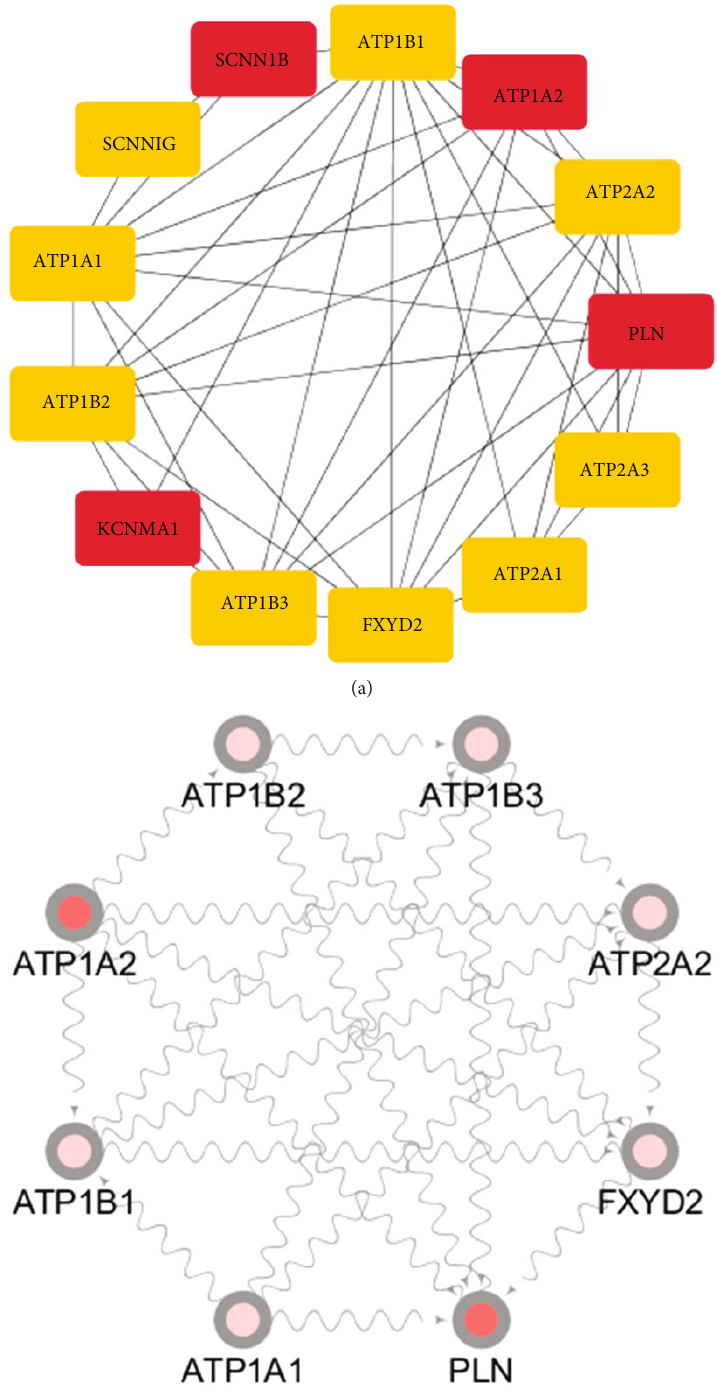
Figure 4: (a) The fi rst four hub genes of 12 DEGs in cytoHubba. (b) Two hub genes in